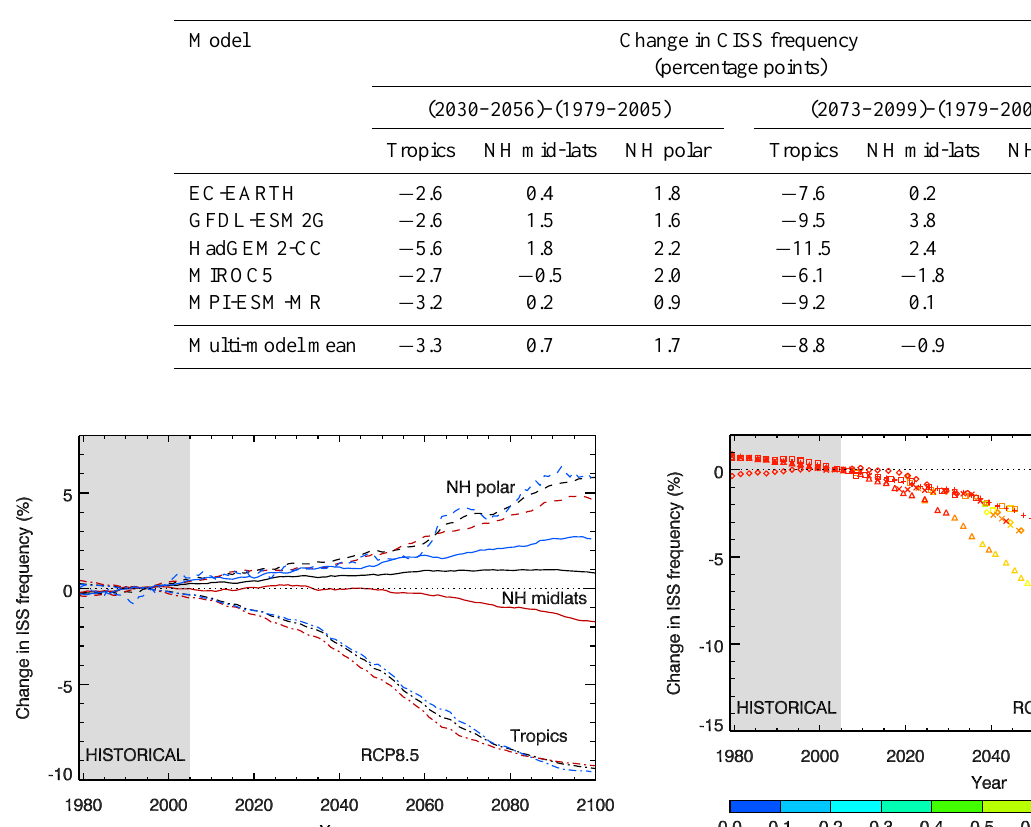
Table 2. Changes to the annual-mean frequency of CISS at 250hPa from the RCP8.5 simulation minus the historical simulation, for the subregions of interest. The change is shown for two time periods: the middle and end of the 21st century.